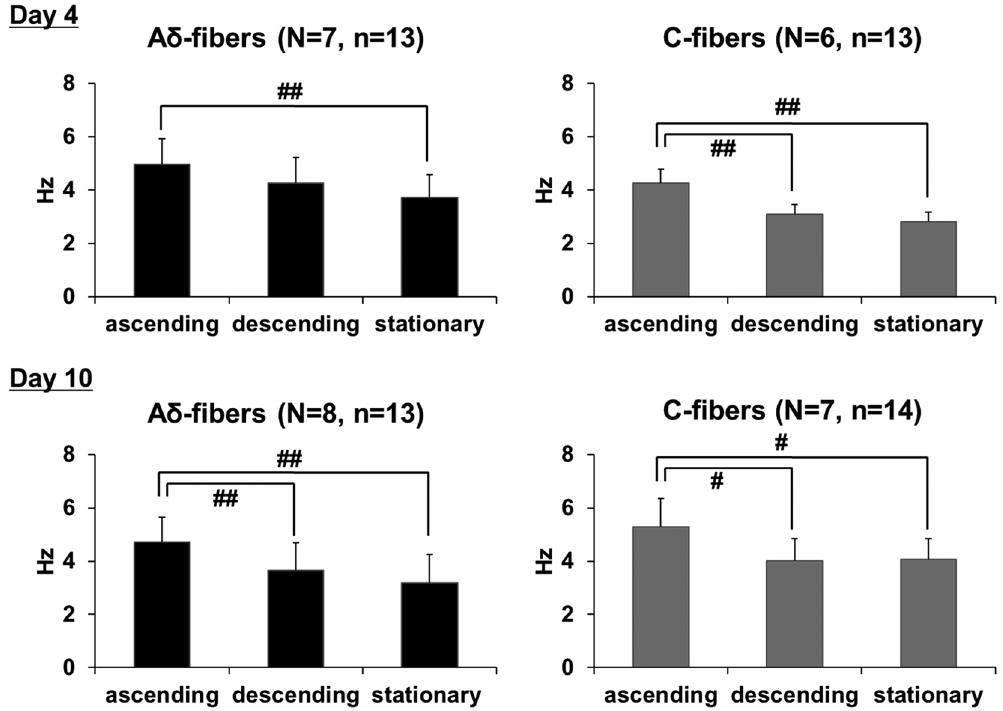
Figure 4. SAAs responses in the BOO rats during three phases of the microcontractions on filling CMG. The vertical axis indicates firing rate of SAAs. Values are expressed as mean ± SEM. # P < 0.05, ## P < 0.01: significant differences between each phase (repeated measures ANOVA followed by Tukey’s multiple comparison